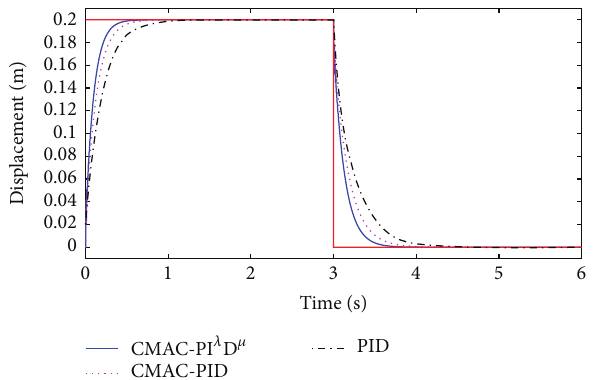
Figure 8: Comparison of displacement